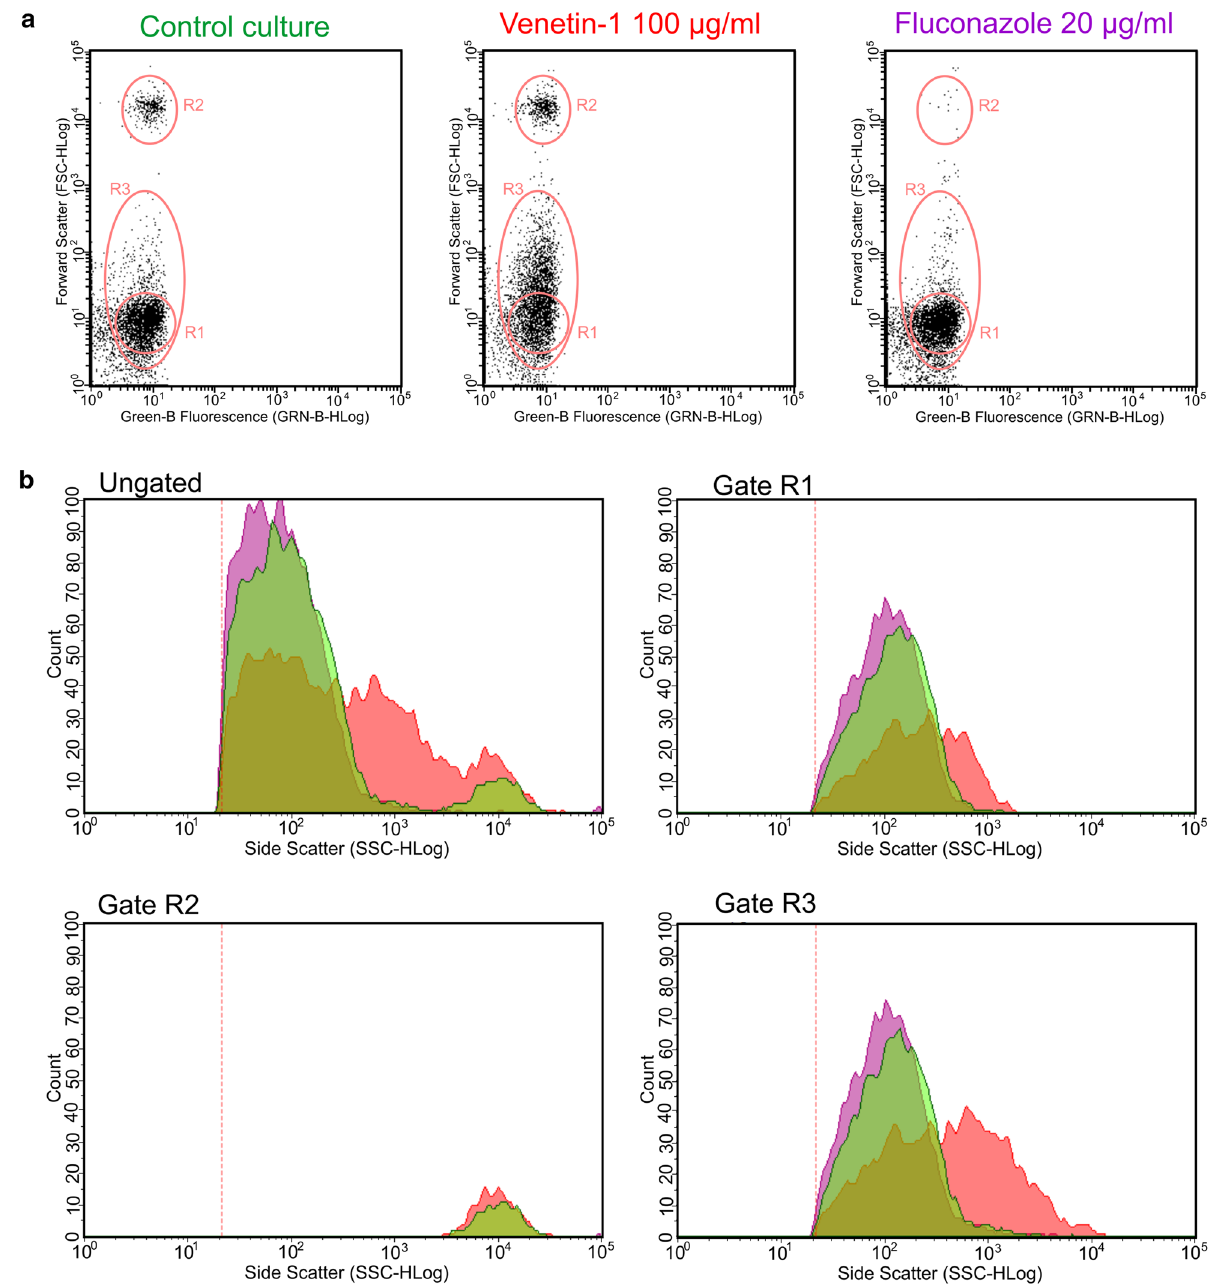
Figure 7. ( a ) Flow cytometry analysis of active mitochondria with Rhodamine 123. Dot-plots of the control culture, cells after the treatment with Venetin-1 at 100 µg mL -1 , and in the variant with fluconazole at 20 µg mL -1 . R1- cells with regular mitochondria; R2- aggregates; R3- cells with active mitochondria. ( b ) Gated regions after flow cytometry analysis: R1-cells with regular mitochondria; R2- aggregates; R3- cells with active mitochondria. Histograms present the profile of the cell cultures in the gated regions. Green—control sample, red—cells after the treatment with Venetin-1 at 100 µg mL -1 , purple—cells subjected to fluconazole at 20 µg mL −1